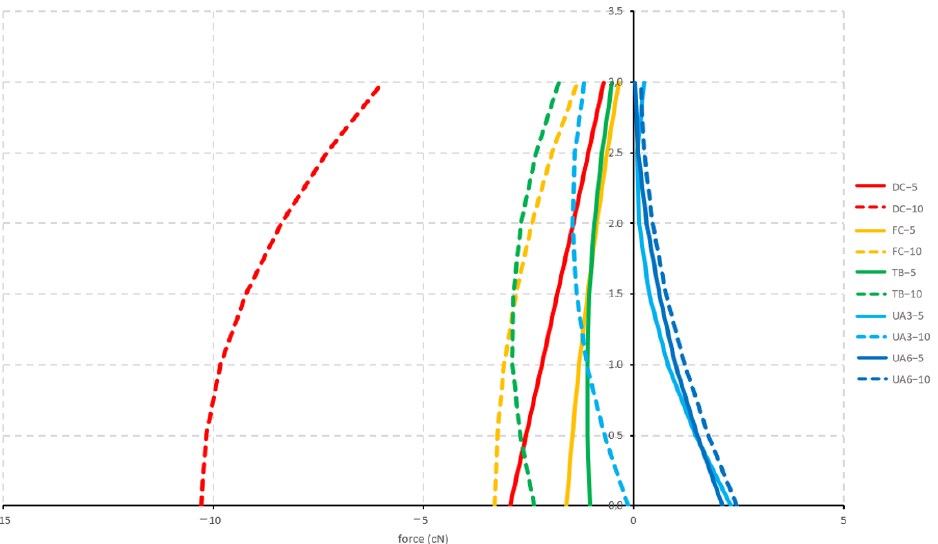
Figure 9. Sagittal forces generated by the arch-formed configurations (see Figure 2) d uring deacti- vation (protrusive; positive values; retrusive: negative values). Tested cantilever configurations origin from Figure 2.